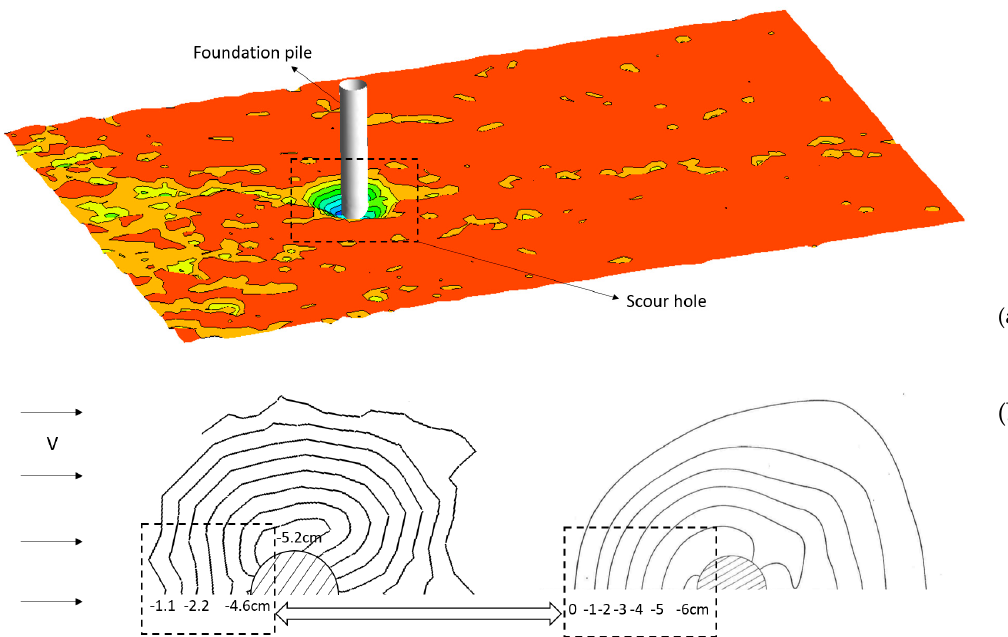
Figure 9. The topographic contour of the local scour shapes after scour equilibrium of model T1 and Mellive’s experimental result: ( a ) the seabed profiles after scour equilibrium simulated by the proposed scour model; ( b ) contour map of the equilibrium scour hole simulated by a numerical model (left), and contour map of equilibrium scour hole in the experiment (right).